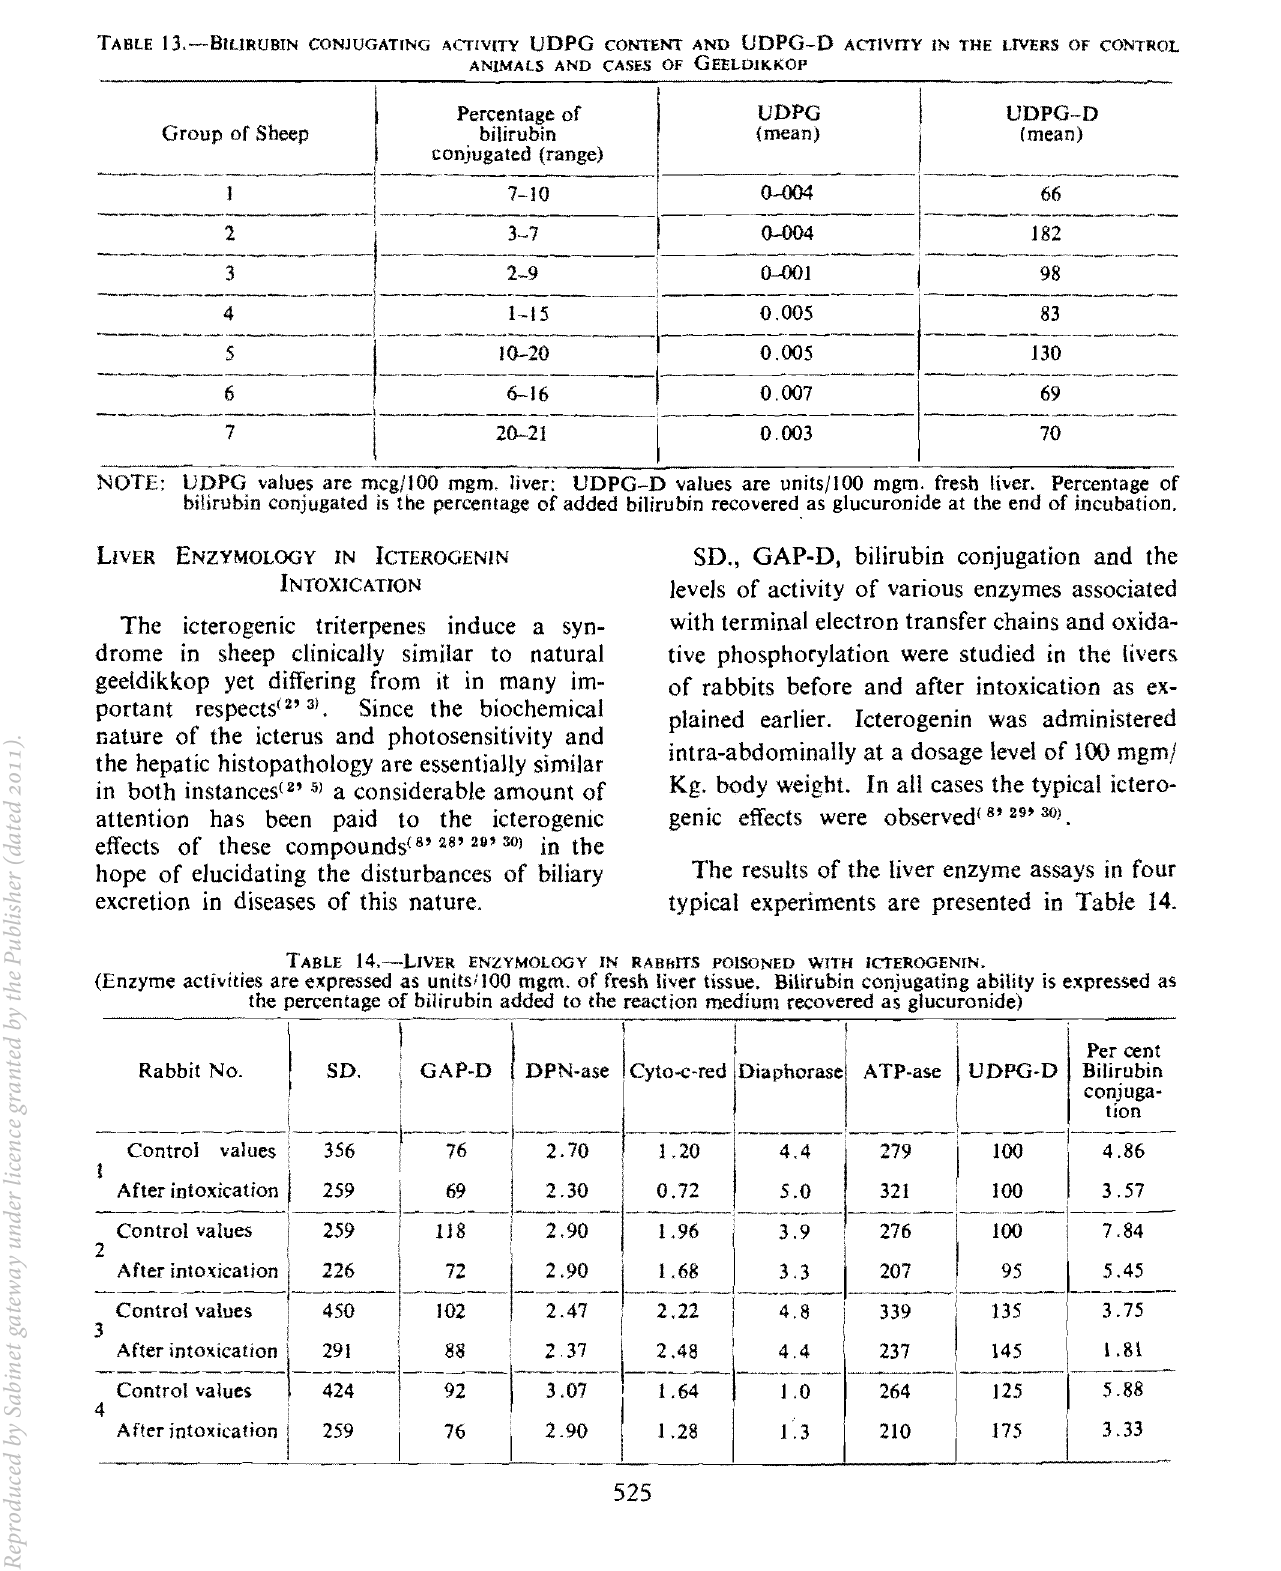
TABLE 13.-BllIRUBIN CONJUGATING ACTlVITY UDPG CONTENT AND UDPG-D ACTIVITY IN THE LIVERS OF CONTROL ANIMALS AND CASES OF GEELDIKKOP Percentage of